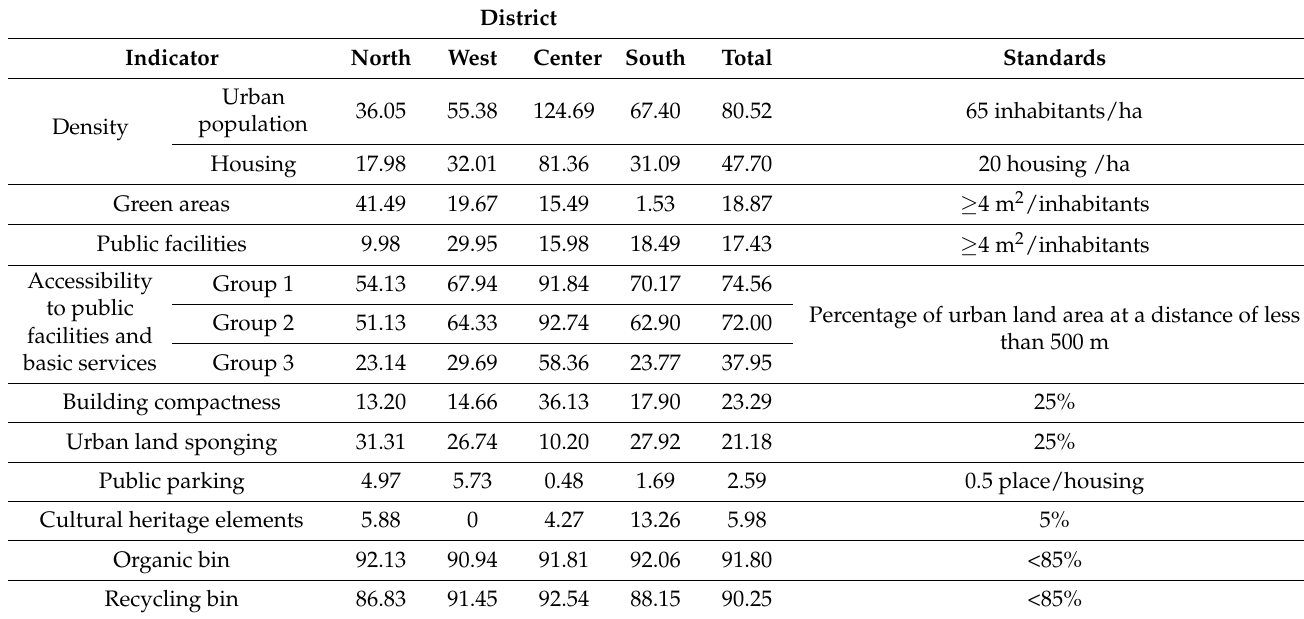
Table 2. Minimum standards and numerical results at district and complete city level for the indicators